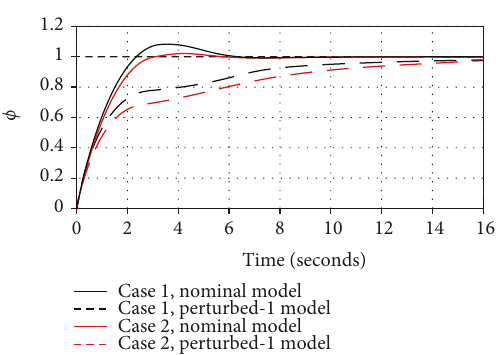
Figure 12: Step responses at design point 7 (clean) using CAS gains in Table